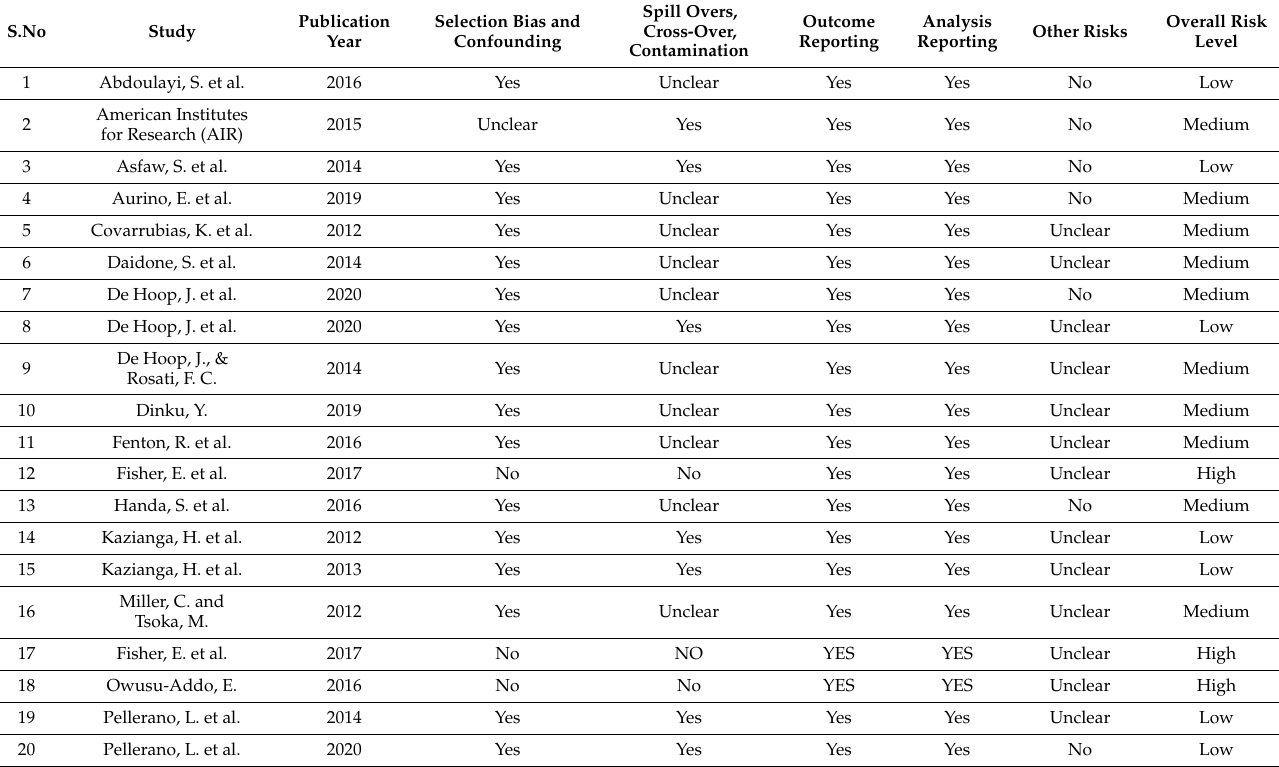
Table A2. Included Studies Risk of Bias